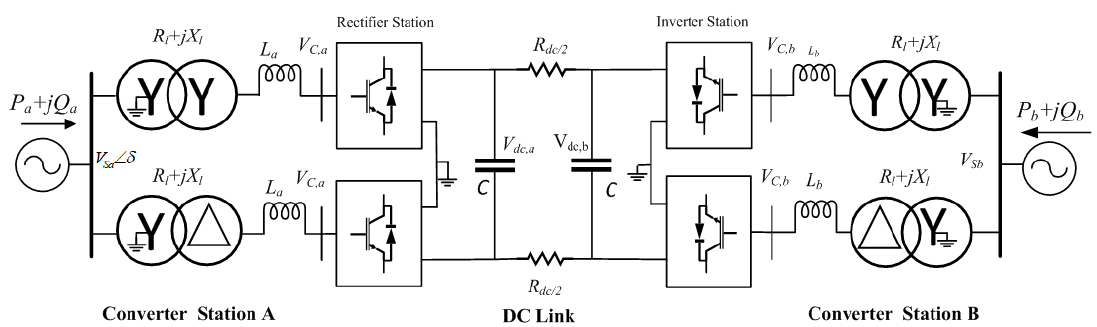
Figure 12. The HVDC light system interconnecting two power grids